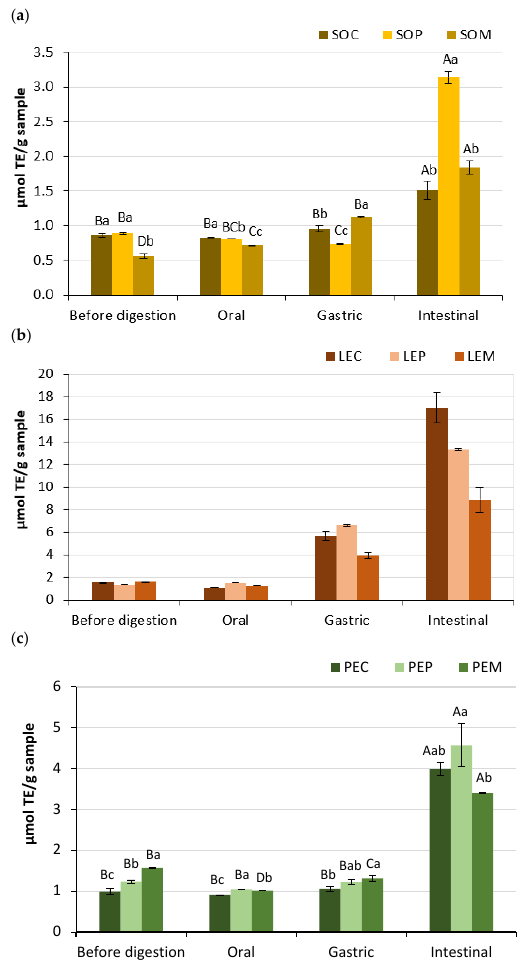
Figure 3. Ferric-reducing antioxidant power of legume pastes from ( a ) soybean, ( b ) lentil, and ( c ) pea subjected to different cooking methods (SOC, ordinary cooked soybean; SOP, pressure-cooked soybean; SOM, microwave-cooked soybean; LEC, ordinary cooked lentil; LEP, pressure-cooked lentil; LEM, microwave-cooked lentil; PEC, ordinary cooked pea; PEP, pressure-cooked pea; PEM, microwave-cooked pea). Capital letter indicates significant differences between phases (before digestion, oral, gastric, and intestinal digestion) within the same legume sample and treatment ( p < 0.05), whereas lowercase letter indicates significant differences between treated samples (cooking, pressure cooking, and microwave) within the same legume and phase ( p < 0.05).